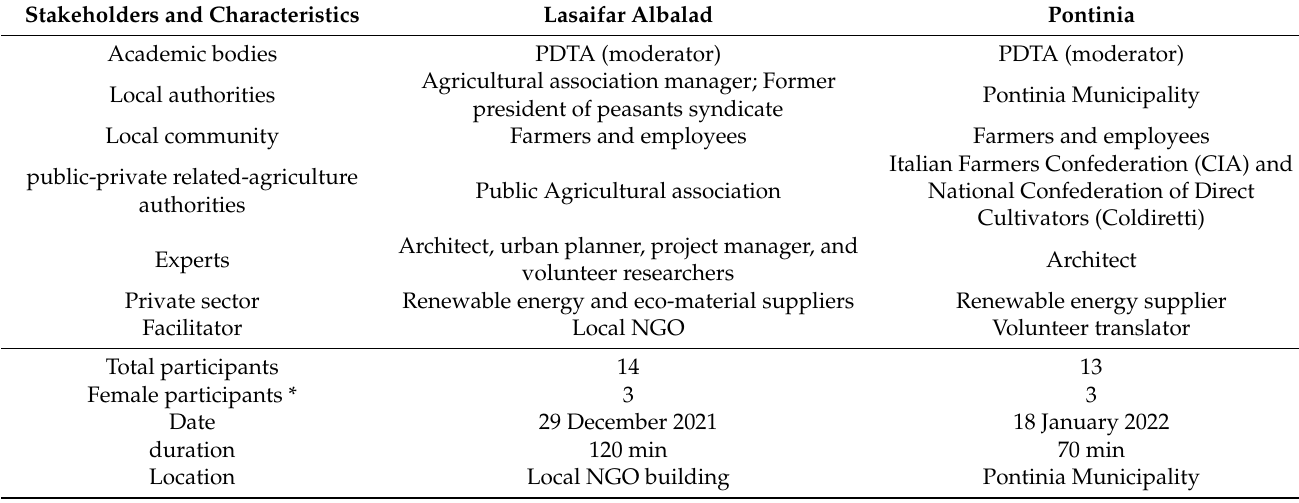
Table 4. The characteristics of the engaged stakeholders in the two focus